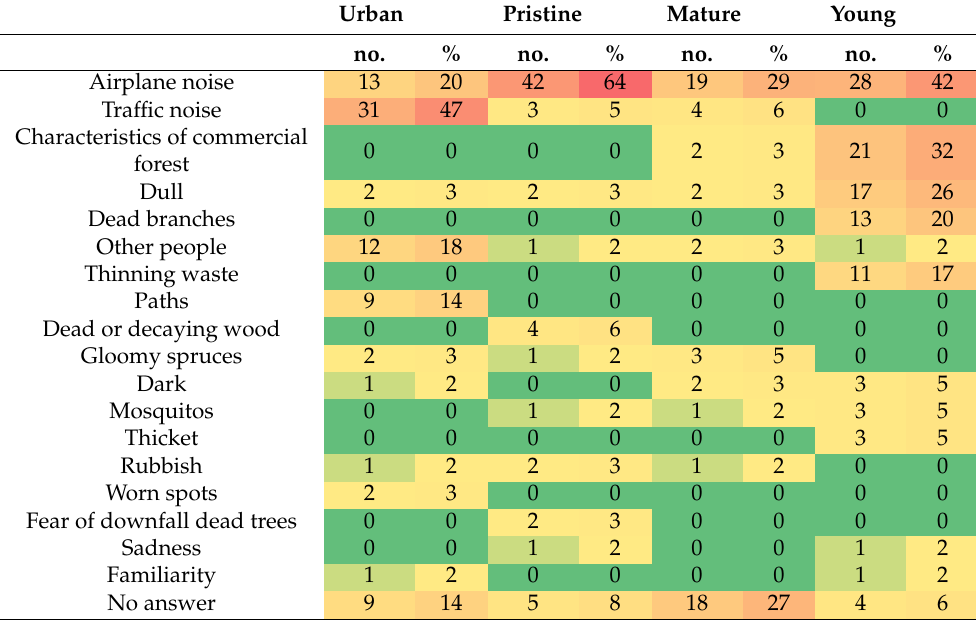
Table 5. The number and proportion of characteristics mentioned that people did not like in the forests. The stronger red, the more not liked responses, and the stronger green, the less not liked responses. Urban Pristine